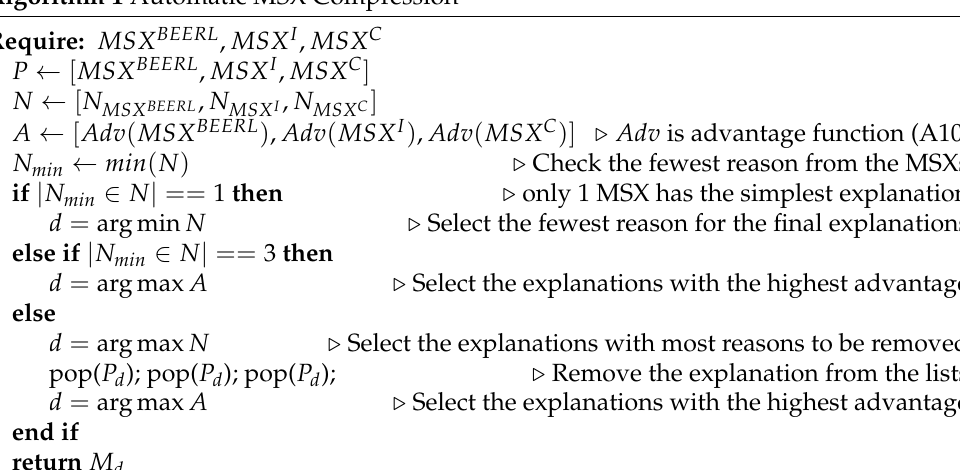
Algorithm 1 Automatic MSX